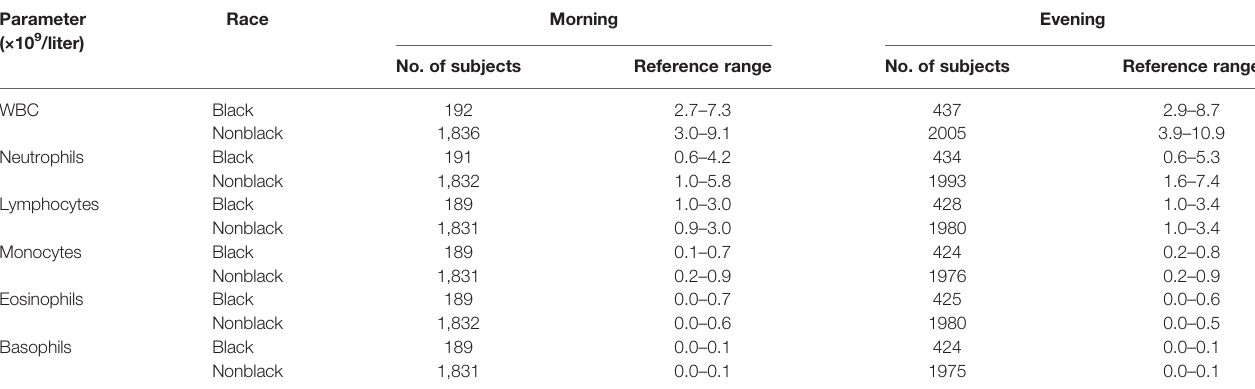
TABLE 5 | Estimated reference ranges of white blood cell (WBC), neutrophils, lymphocytes, monocytes, eosinophils, and basophils by race and time of day. Parameter (×10 9